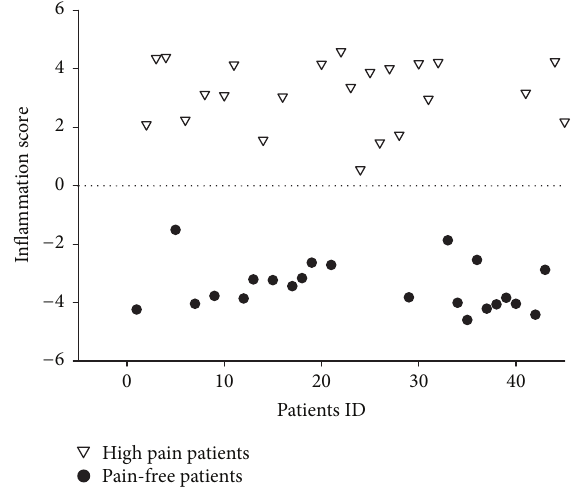
Figure 2: Linear discriminant analysis. An inflammation score was computed for each patient as a weighted average of the protein expressionlevels forthe41biomarkers(FDR < 0.10). Thescoreswere adjusted so that positive values indicate an ongoing inflammation and negative values indicate lack of inflammation. The scores are plotted for all patients (patient ID 1–45) in the